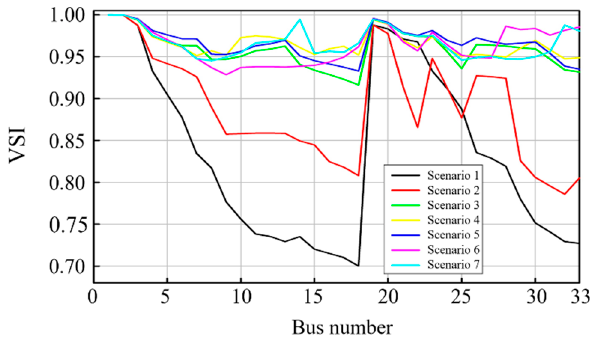
Figure 4. A comparison of VSI at each bus of 33-bus system for seven scenarios performed by proposed ASFLA.